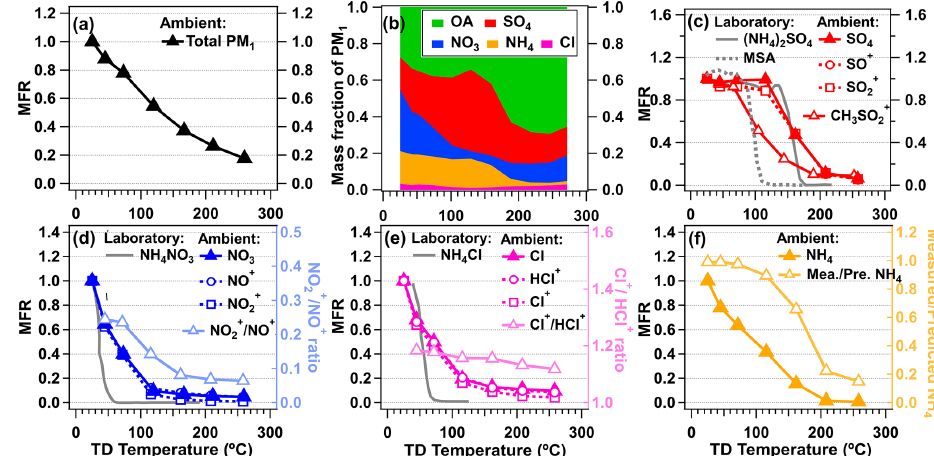
Figure 6. (a) Mass fraction remaining (MFR) of total NR-PM 1 . (b) Fraction of main components in NR-PM 1 as a function of TD temper- ature. (c) Variations in the average MFR of the inorganic species with their corresponding constituent ions as functions of TD temperature: (c) sulfate; (d) nitrate; (e) chloride; (f) ammonium. In addition, MFRs of pure ammonium salts of sulfate, nitrate, and chloride as well as methanesulfonic acid (MSA) measured in this study are shown for comparison. Particle acidity calculated as the measured NH 4 vs. predi- cated NH 4 assuming a neutral balance from the aforementioned cations as a function of TD temperature is also shown on the right axis of panel (f)